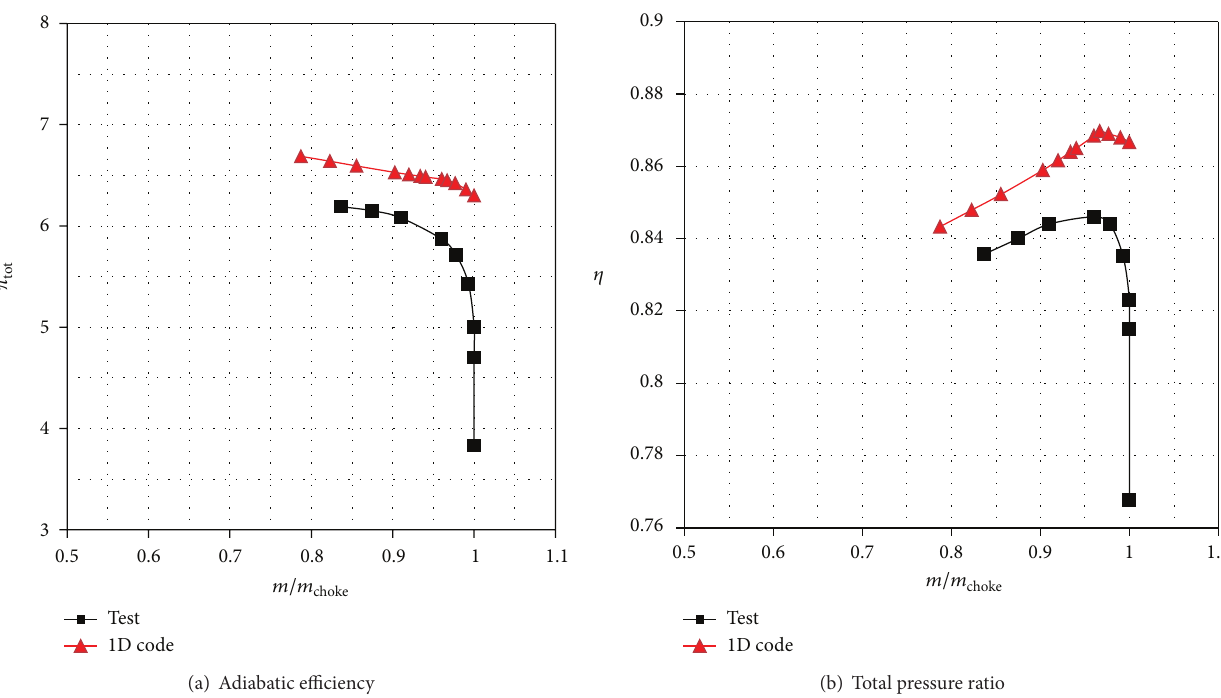
Figure 5: Performance curves between 1-D and test.